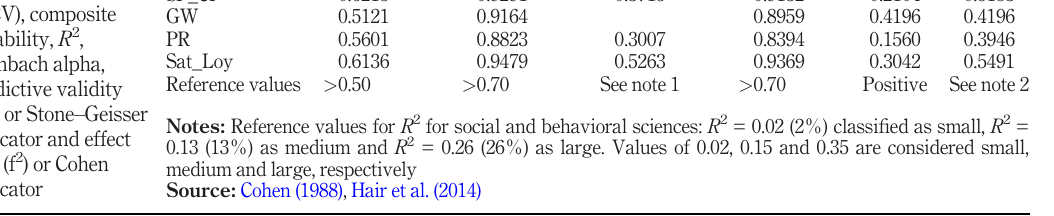
Table III. Discriminant validity evaluation